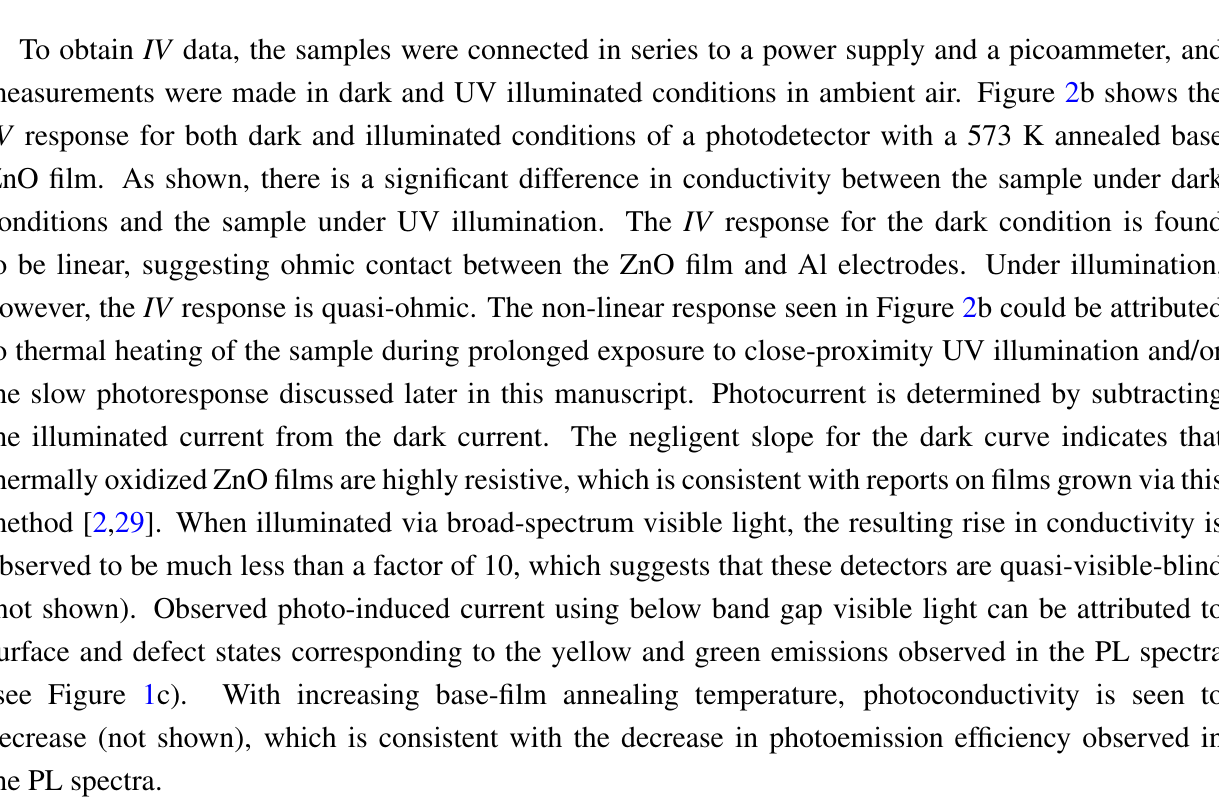
Figure 3. Photocurrent transients for films annealed at 573 and 873 K and held at 1 V bias. The first vertical dotted line indicates when illumination was turned on. The second vertical dotted line indicates when illumination was turned